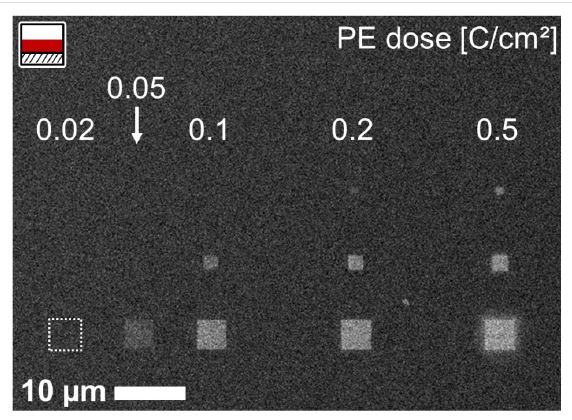
Figure 2: SEM micrograph of square EBID structures of different sizes and primary electron doses (as indicated), prepared on a 100 nm Si 3 N 4 membrane using Co(CO) 3 NO. The structures were prepared in one experimental run, from left to right, top to bottom. After the EBID step, the precursor was further supplied to allow for autocatalytic growth. The total growth time increases from 198 min (bottom right structure) to 230 min (top left structure). The minimum electron dose for detectable deposition is about 0.05 C/cm 2 , while a dose of